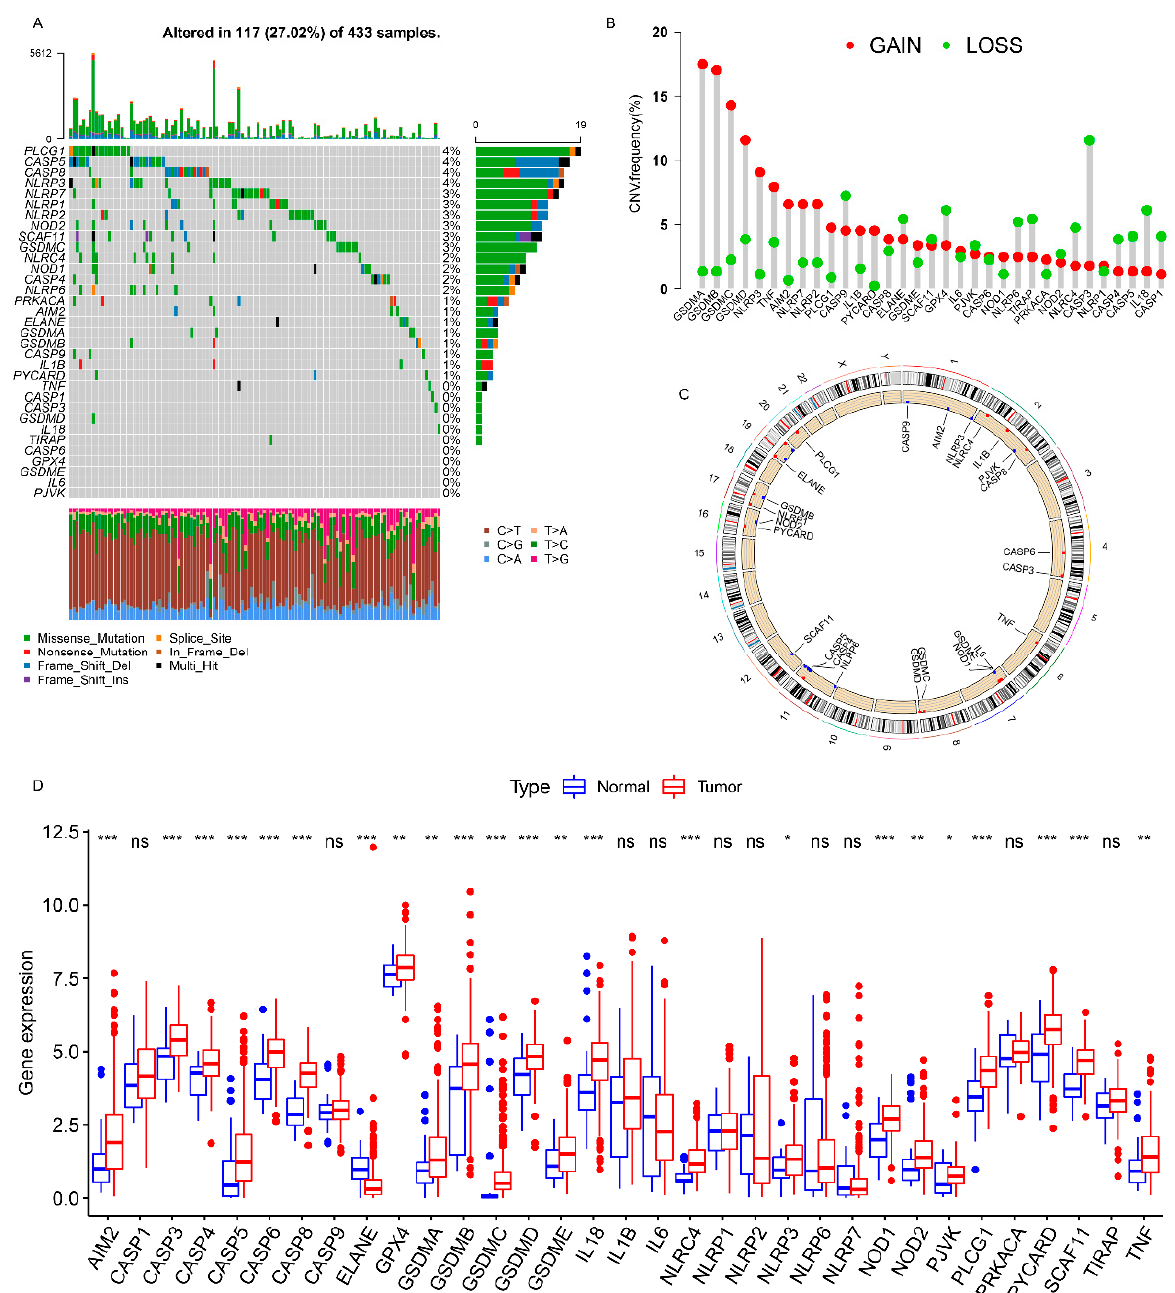
Figure 1. Landscape of genetic alterations of PRs in GC. ( A ) The mutation frequency of PRs in 433 patients with GC. The number on the right represented the mutation frequency of the PRs. Each column corresponds to one of the 117 TCGA samples (out of the 433) where there was at least one genetic alteration in the PRs. ( B ) The CNV mutation frequency of the PRs. The column showed the alteration frequency. The amplification frequency, red dot; the deletion frequency, green dot. ( C ) The location of the CNV alteration of the PRs on the chromosomes. ( D ) Differential expression analysis of the PRs between normal tissues and GC tissues. * p < 0.05; ** p < 0.01; *** p < 0.001.